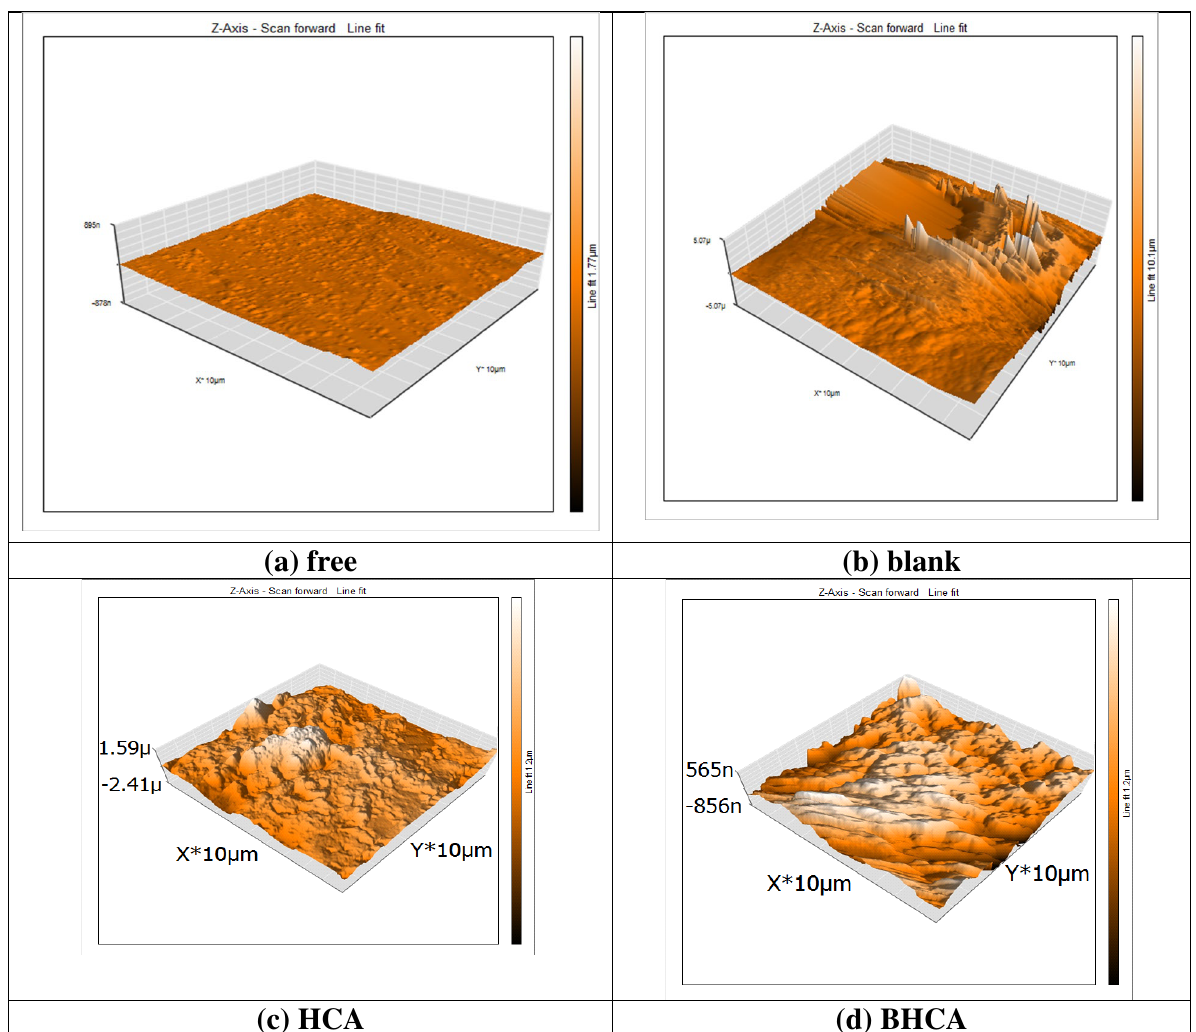
Figure 11. AFM spectra for ( a ) 3D image of free polished CS surface ( b ) 3D image of CS in 1 M HCl in absence of inhibitors ( c ) 3D image of CS in 1 M HCl in presence of 60 ppm of inhibitor HCA ( d ) 3D image of CS in 1 M HCl in presence of 60 ppm of inhibitor